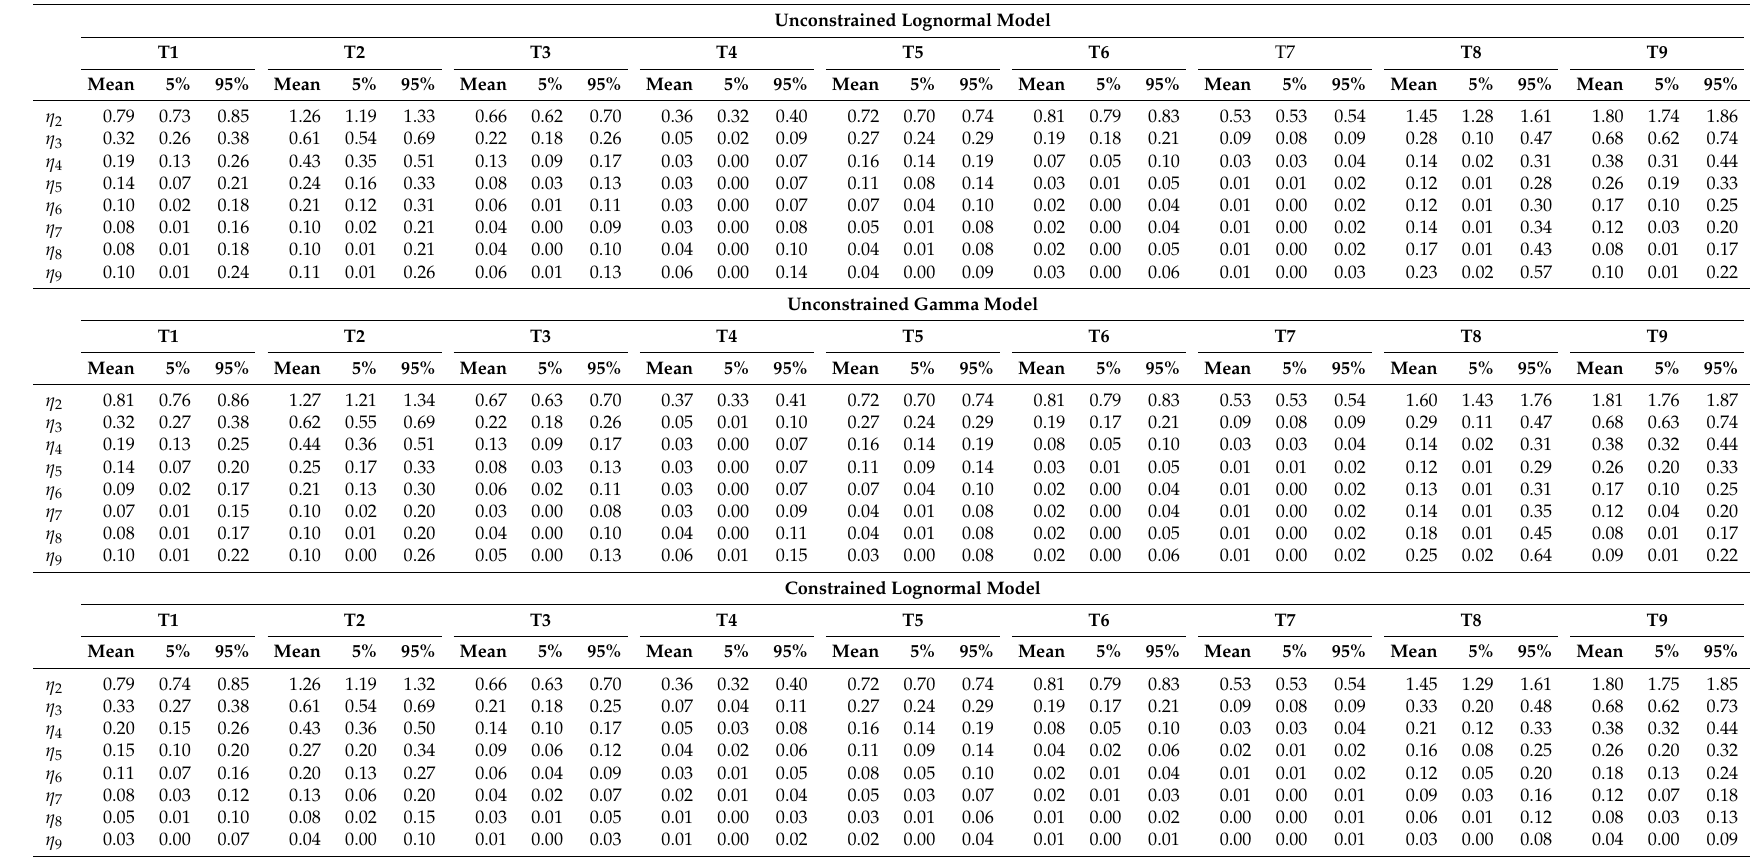
Table 3. Estimated regression coefficients for marginal